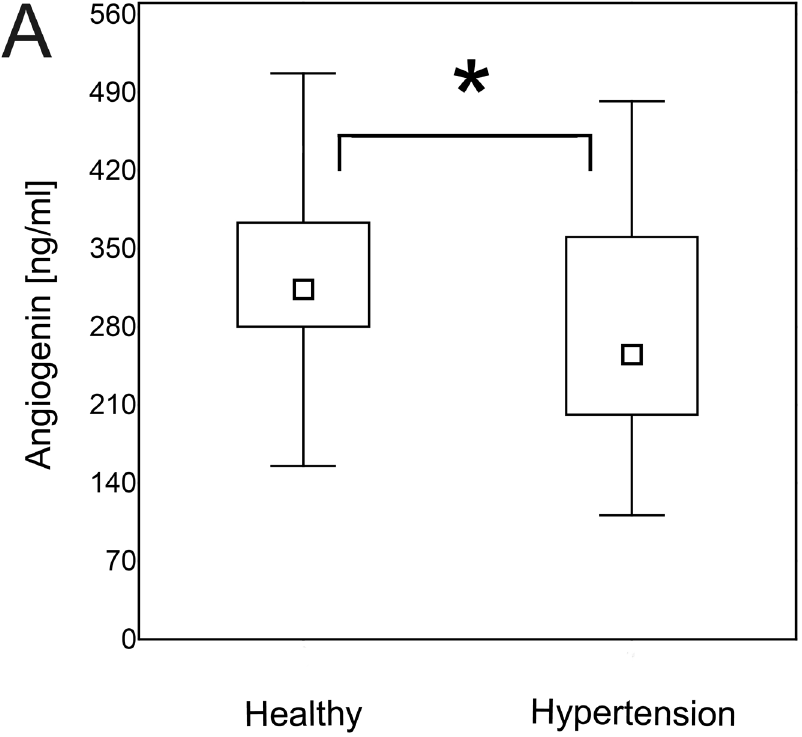
Fig 5. Angiogenin concentration in hypertension. Patients with hypertension were characterized by lower serum concentration of angiogenin than healthy individuals (Mann- Whitney U test; p = 0.01). The data are presented as medians (symbols inside the boxes), 25 – 75% percentiles (boundaries of the boxes) and minimum — maximum (error bars outside the boxes). Statistical significance (p < 0.05) is marked with “ * ”